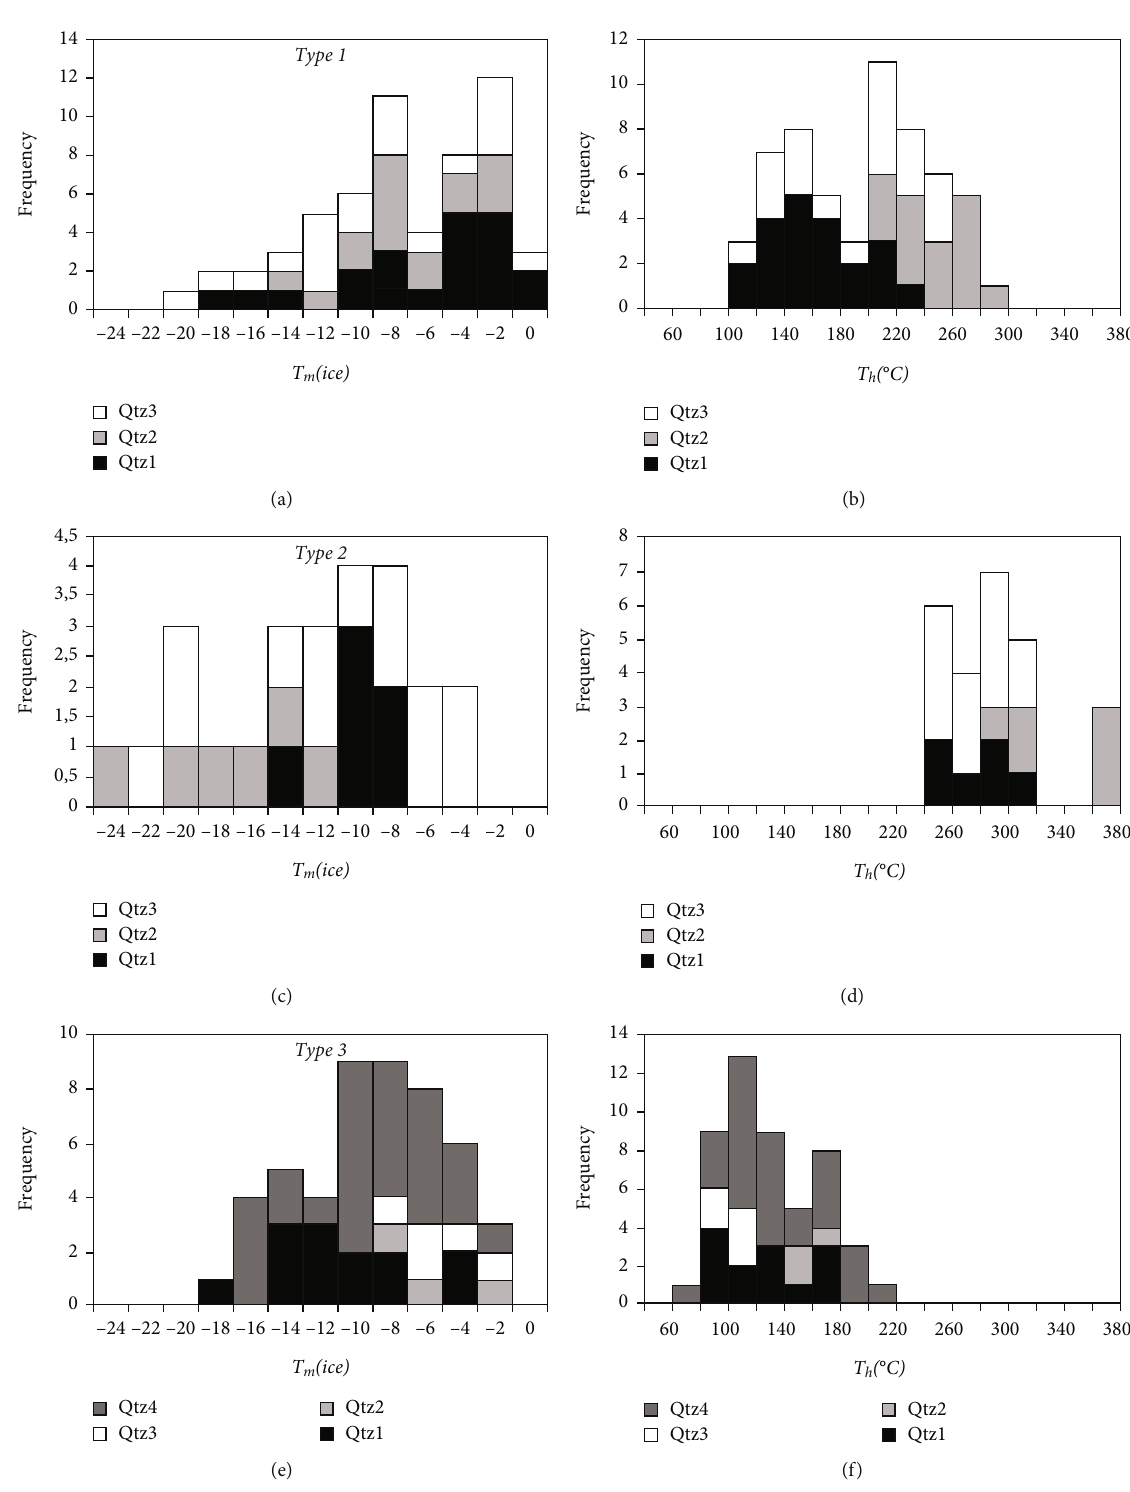
T m ð ice Þ ) based on microthermometric and T h of H O-N -CH ± CO -(salt) inclusions ice Þ 2 2 4 2 and T h of H O-(salt) inclusions (type 3). ice Þ 2